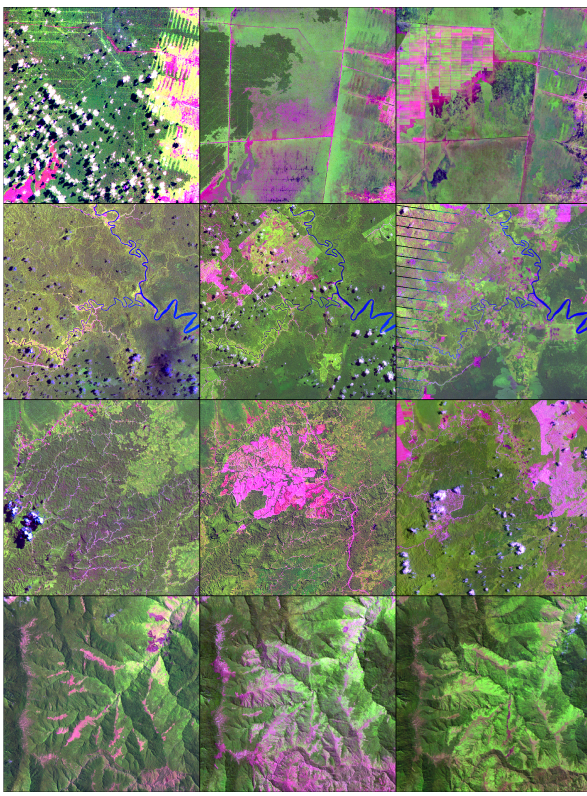
Fig. 6. Examples of forest change patterns from Papua and continental Southeast Asia (Cambodia, Laos and Myanmar), taken from Landsat TM/ETM imagery for 1990-2000-2010 for selected sample units. Top row, site S02-E139, Papua/Indonesia: logging; Row 2, site N12-E106, Cambodia: agricultural expansion and rubber plantations; Row 3, site N20-E102, Laos: shifting cultivation; Bottom row, site N16-E095, Myanmar: mangrove forest conversion for aquaculture.